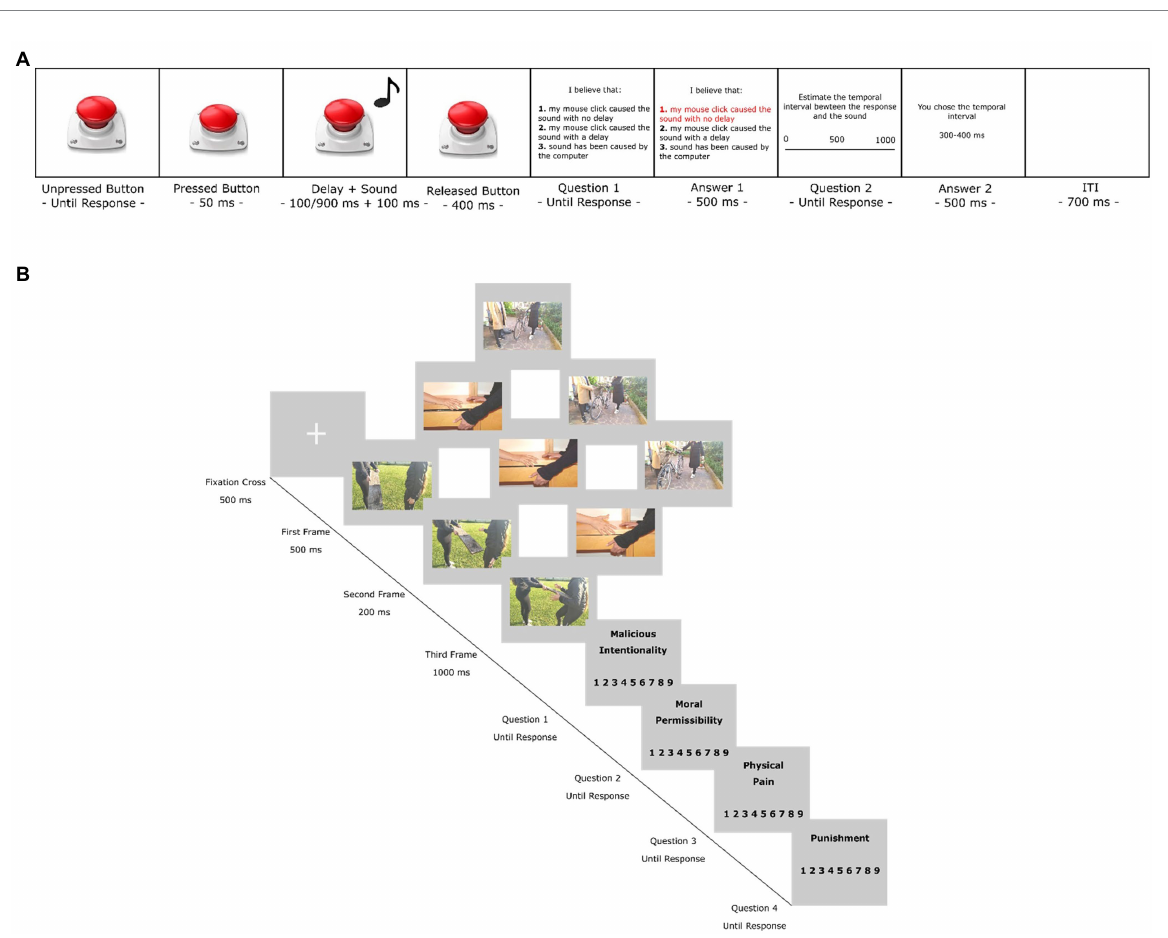
FIGURE 1 Experimental Paradigms. (A) Intentional Binding task: A first screen with the image of an unpressed button located at the center of the monitor was presented until a response was made (Action condition) or it remained on the screen for 700 ms (Control condition). In the Action condition, participants were asked to click with the mouse to press the button, while in the Control condition, the button was pressed automatically. As soon as the response was made by clicking the mouse (Action condition) or automatically triggered (Control condition), the button on the screen was depressed for 50 ms. Then, the button on the screen returned to an unpressed state and a sound was emitted for 100 ms after a random delay (100–900 ms). The button remained visible on the screen for another 400 ms. After that, participants were asked to respond to two questions investigating, explicit and implicit SoA, respectively. A 500 ms long visual feedback screen confirmed their choices. The interval between trials lasted 700 ms. (B) Moral Cognition task: Each trial started with a fixation cross (500 ms) followed by the videoclip (first frame – 500 ms,